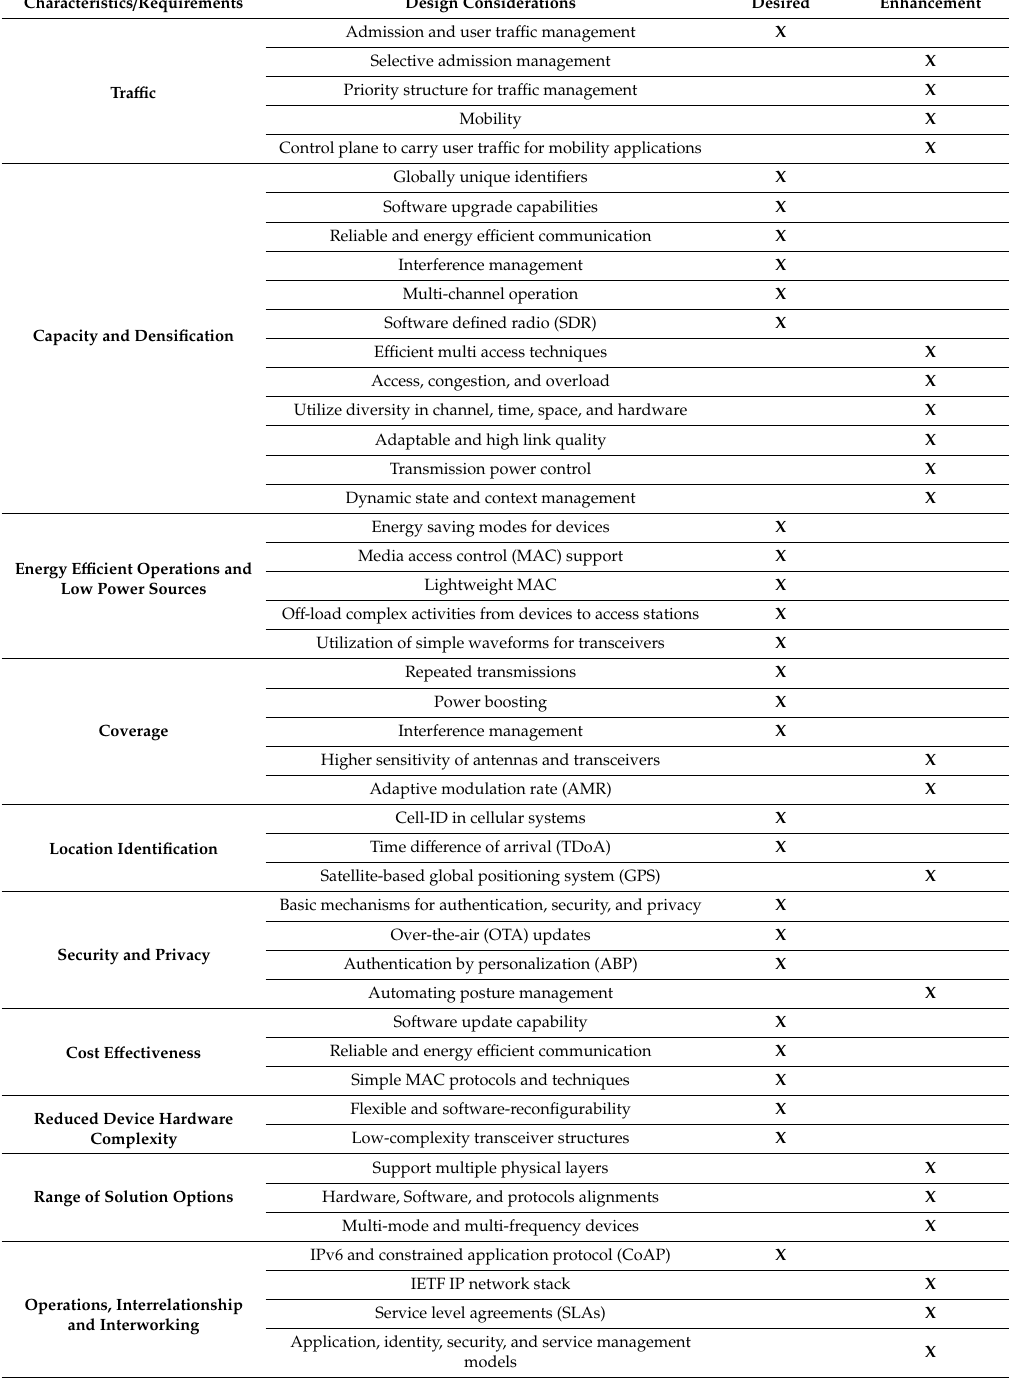
Table 3. Design Considerations Summary for LPWAN